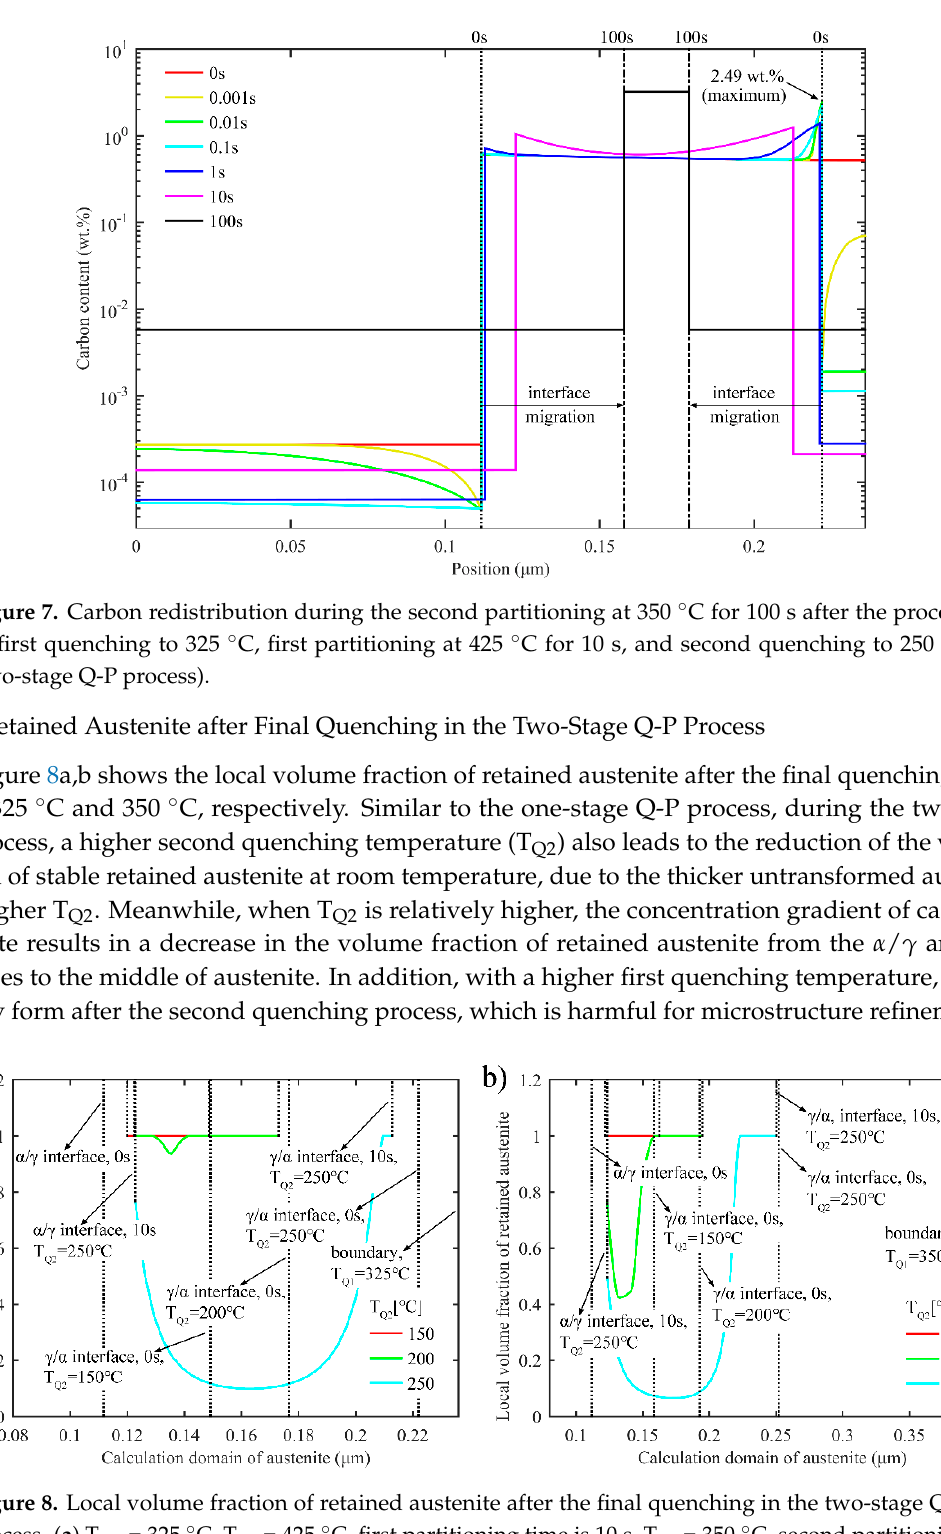
Figure 9. ( a ) Volume fraction of austenite in the second partitioning process and retained austenite after quenching to room temperature as a function of the second partitioning time during the two- stage Q-P process. T P1 = 425 ° C, the first partitioning time is 10 s, T P2 = 350 ° C and the second partitioning time is 100 s. The quenching temperature is: Ⅰ : T Q1 = 325 ° C, T Q2 = 150 ° C; Ⅱ : T Q1 = 325 ° C, T Q2 = 200 ° C; Ⅲ : T Q1 = 325 ° C, T Q2 = 250 ° C; Ⅳ : T Q1 = 350 ° C, T Q2 = 150 ° C; Ⅴ : T Q1 = 350 ° C, T Q2 = 200 ° C; Ⅵ : T Q1 = 350 ° C, T Q2 = 250 ° C; ( b ) Maximum volume fraction of retained austenite and the corresponding partitioning time for reaching the maximum value at different second partitioning temperature. As previously analyzed, the second partitioning time strongly affects the microstructure and the volume fraction of stable retained austenite. Figure 10a–c depicts the final microstructure when the second partitioning time is 10 s, 20 s, and 30 s, respectively. Obviously, shorter second partitioning times result in the formation of new high-carbon martensite sheet M 3 , while longer second partitioning times give rise to a higher volume fraction of stable retained austenite. Consequently, the microstructure can be associated with the content of retained austenite through the use of an appropriate second partitioning time. In this study, the second partitioning time of 20 s makes a good combination of suitable microstructure and higher content of retained austenite. Finally, through the two-stage Q-P process, the microstructure with alternating distribution of small-sized low-carbon martensite plates, retained austenite, and high-carbon martensite sheets, in addition to the low- carbon martensite laths, can be obtained, which facilitates microstructure refinement. In addition,